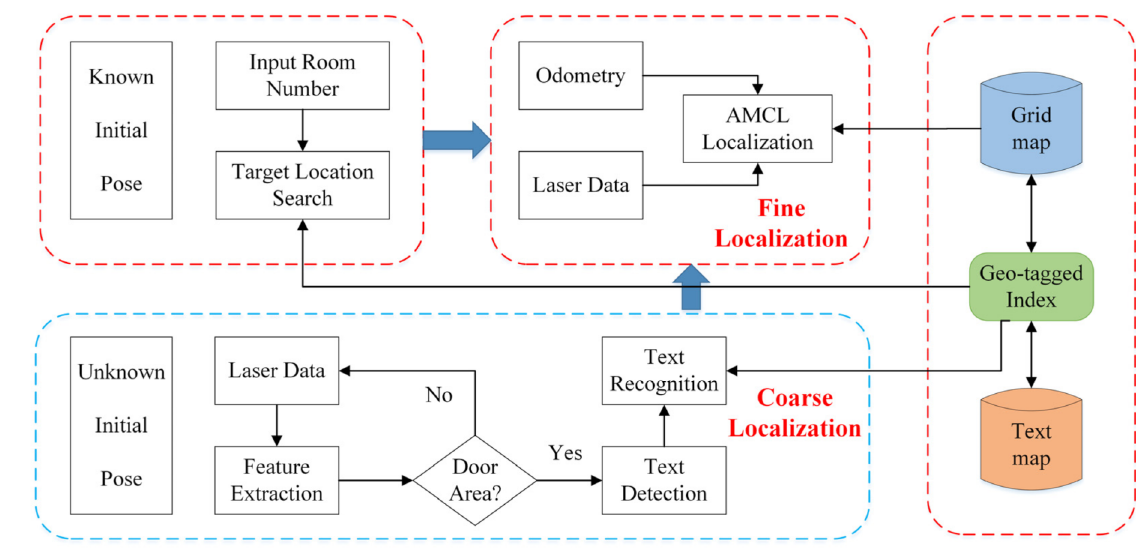
Figure 6. Localization